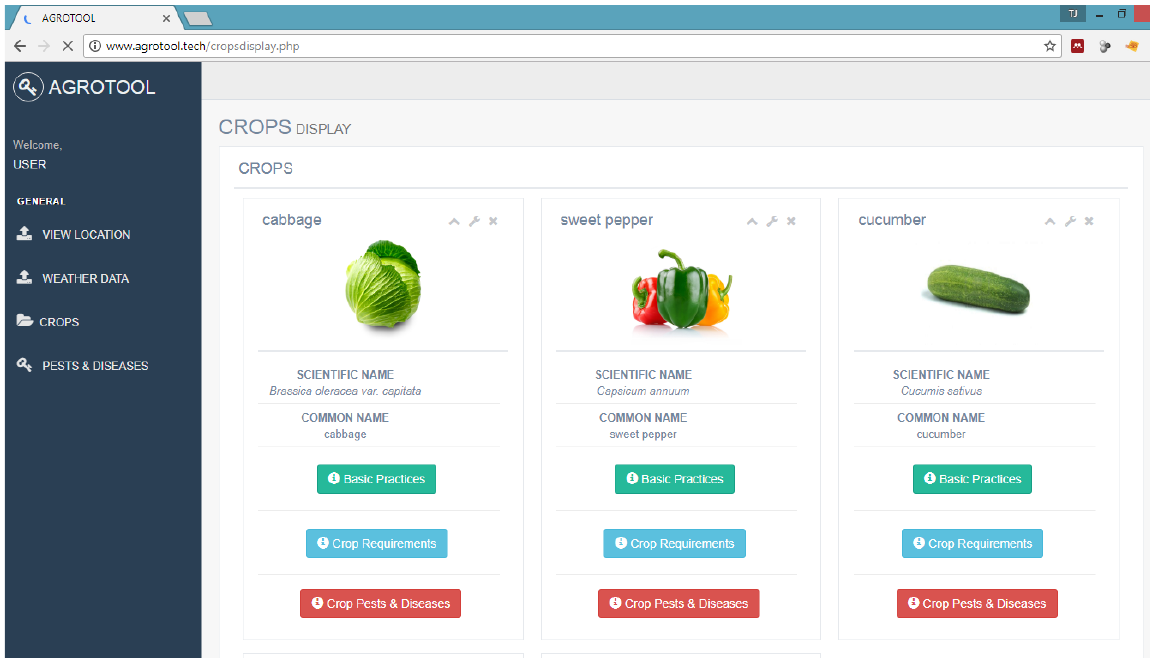
Figure 4. A page for displaying crops with their respective information on requirements, best practices, pests and diseases